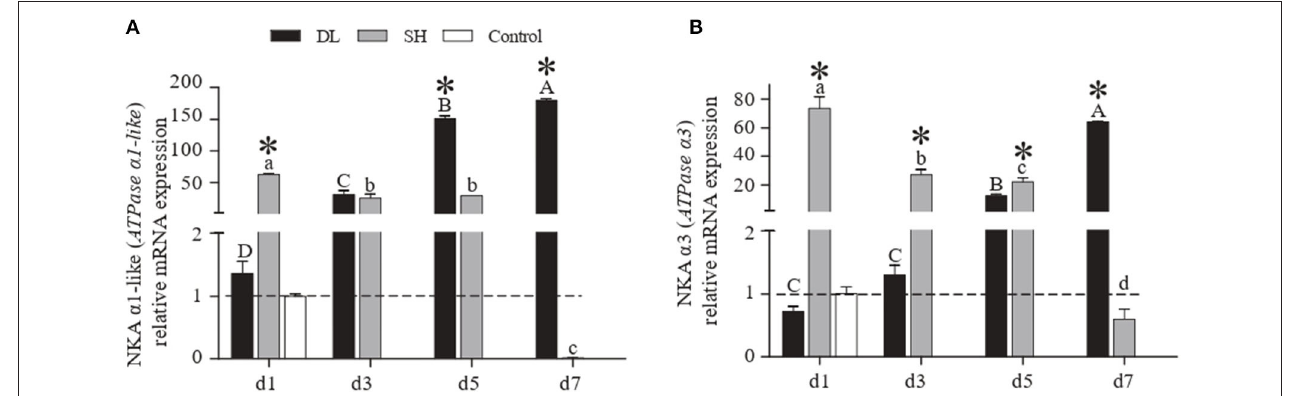
FIGURE 3 | Gill NKA α 1-like ( ATPase α 1-like ) and NKA α 3 ( ATPase α 3 ) mRNA levels ( n = 3) for DL (the alkali form introduced from Lake Dali Nor) and SH (the freshwater form introduced from Songhua River) fish forms. Different uppercase letters indicate significant differences within DL, and different lowercase letters indicate significant differences within SH. The asterisk (*) denotes a significant difference found in the NKA α 1-like or NKA α 3 mRNA levels between DL and SH exposed to bicarbonate AW.